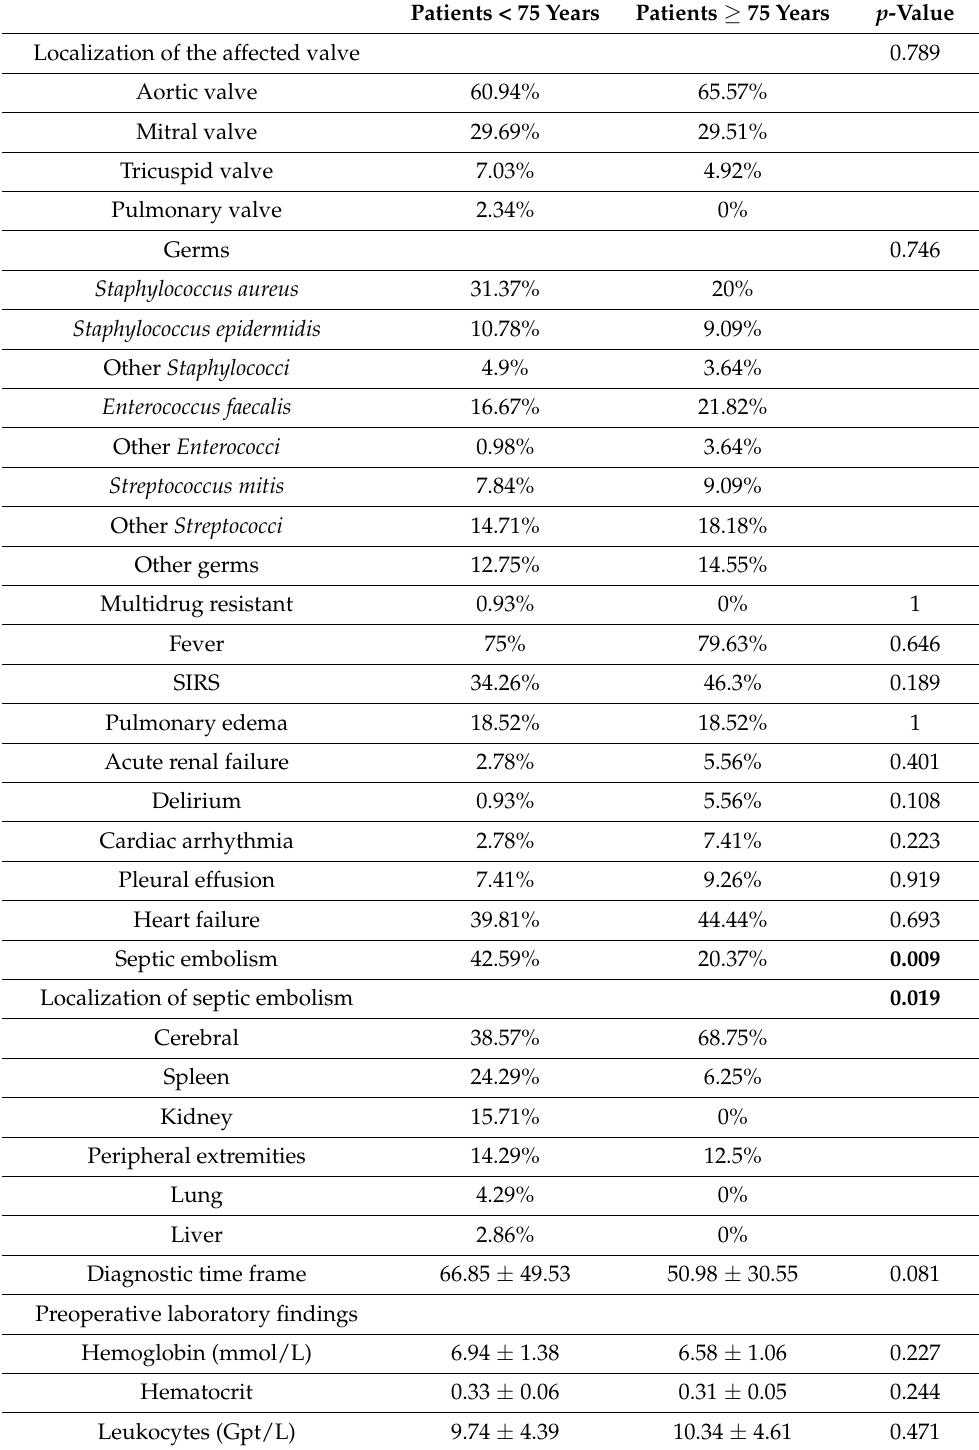
Table 2. Preoperative